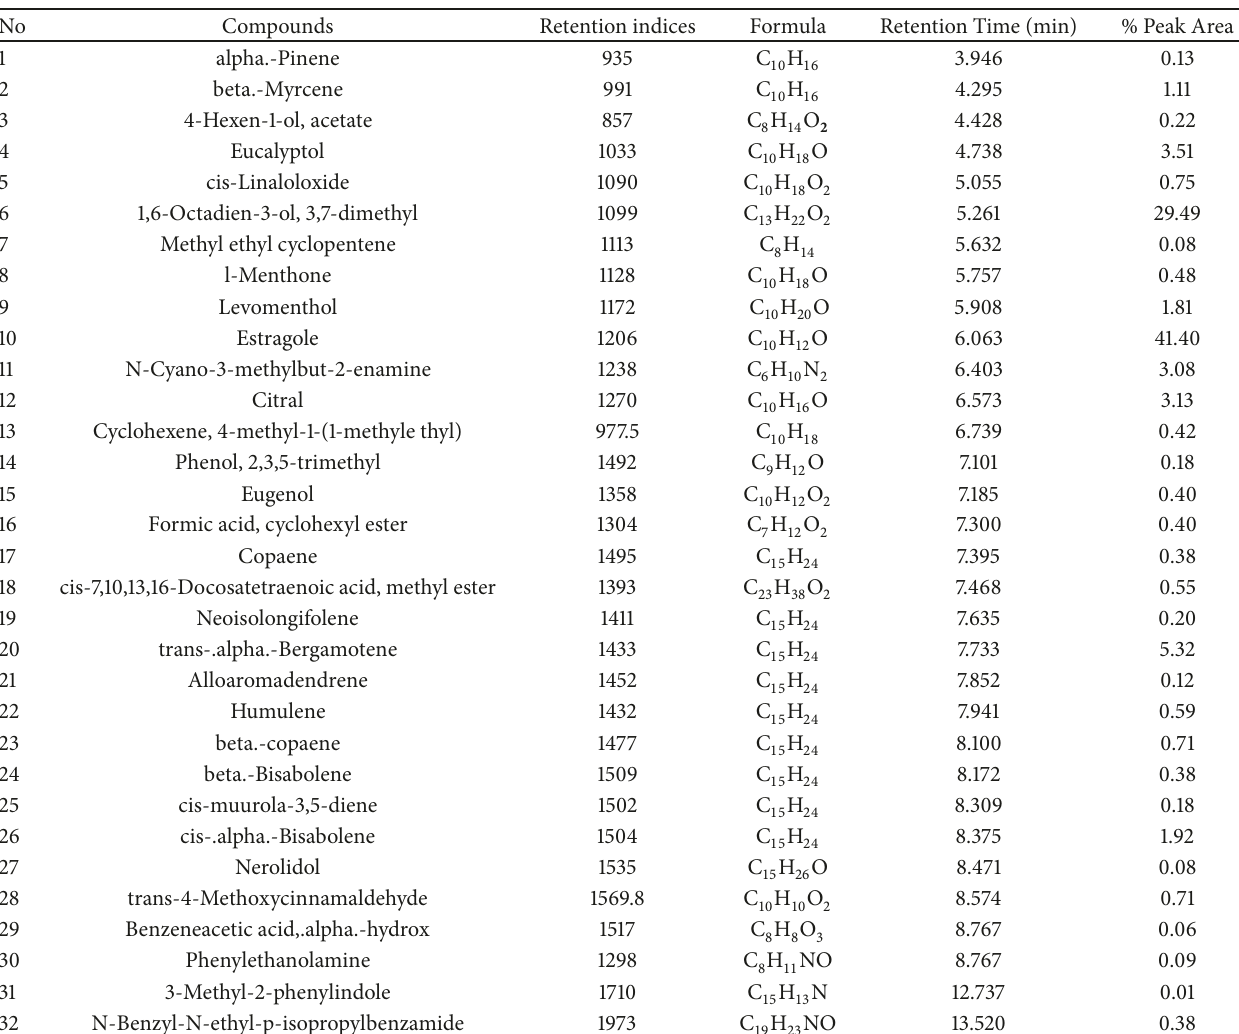
Table 1: Chemical composition of sweet basil leaf essential